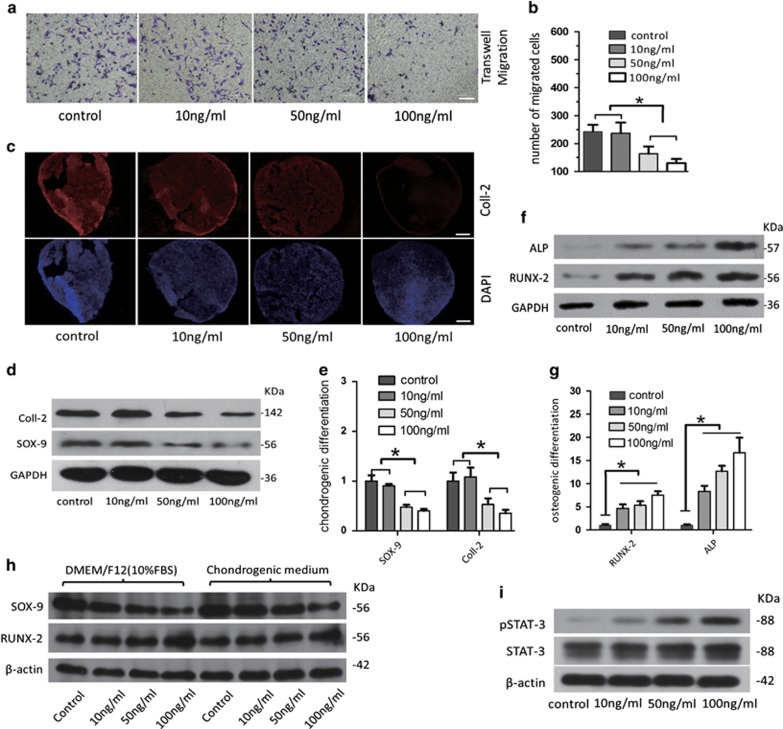
Changes in migration, chondrogenic potential and osteogenic potential were analysed in CPCs that were treated with different doses of leptin. (a) CPCs were treated with different doses of leptin (0 ng/ml as the control or 10, 50  or 100 ng/ml) while growing in culture medium. At 24 h after treatment was begun, the migrated CPCs were stained using crystal violet, and the numbers of CPCs were counted and averaged in five visual fields. (b) A lower number of migrated CPCs was observed in the cells treated with a high dose of leptin than in the control cells. (c) CPCs were grown in a chondrogenic induction system in the presence of leptin (0 ng/ml as the control or 10 , 50 or 100 ng/ml) for 21 days. Pellets were analysed using Coll-2 immunofluorescence and western blot analysis. (d and e) Western blot was performed to analyse the protein level of Coll-2 and SOX-9 in CPCs after 21 days of chondrogenic induction in the presence of leptin (0 ng/ml as the control or 10 , 50 or 100 ng/ml) in vitro. Relative protein abundance of each blot was normalized to the grey value of GAPDH (f and g). CPCs were grown in an osteogenic induction system in the presence of leptin (0 ng/ml as the control or 10, 50  or 100 ) for 7 days. Alkaline phosphatase (ALP) and RUNX-2 were detected using western blot analysis. Relative protein abundance of each blot was normalized to the grey value of GAPDH. ALP levels and the expression of the osteogenic transcription factor RUNX-2 were higher in the cells that were incubated with leptin than in the control cells. (h) The effect of a short duration of exposure to leptin treatment on CPCs cells was evaluated. SOX-9 and RUNX-2 expression were detected in CPCs grown in the presence of leptin (0 ng/ml as the control or 10 , 50 or 100 ng/ml) for 2 days. (i) After 2 days, leptin intracellular signalling (pSTAT-3) was activated at higher levels in CPCs that were treated with high doses of leptin than in the control cells or the cells treated with low doses of leptin. Scale bar, 100 μm. Error bars represent the mean±S.D. *P<0.05 was considered statistically significant